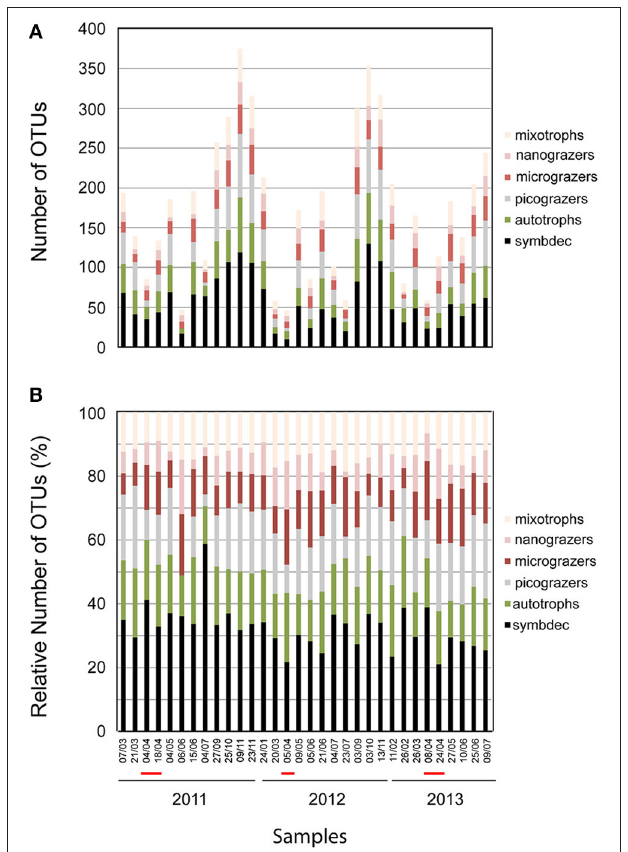
FIGURE 5 | Plot of the total number of OTUs present at each sampling date (red circles), the cumulative number of OTUs (blue circles) based on the new arriving OTUs between two consecutive dates, the cumulative number of SymbDec OTUs (black circles) and the cumulative number of the most abundant SymbDec OTUs, MALV (gray circles) (A) ; and relationship between the number of cumulative OTUs (no SymbDec included to avoid autocorrelation) and SymbDec OTUs, based on the new arriving OTUs between two consecutive dates. The determination coefficient R 2 , the p -value and the 1:1 line are also indicated (B) . The red line on the x-axis indicates periods of the P. globosa